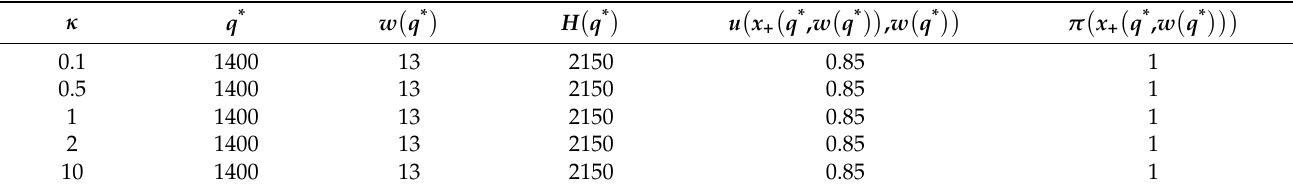
Table 2. Solutions of the proposed model with ϕ = 0.5 .